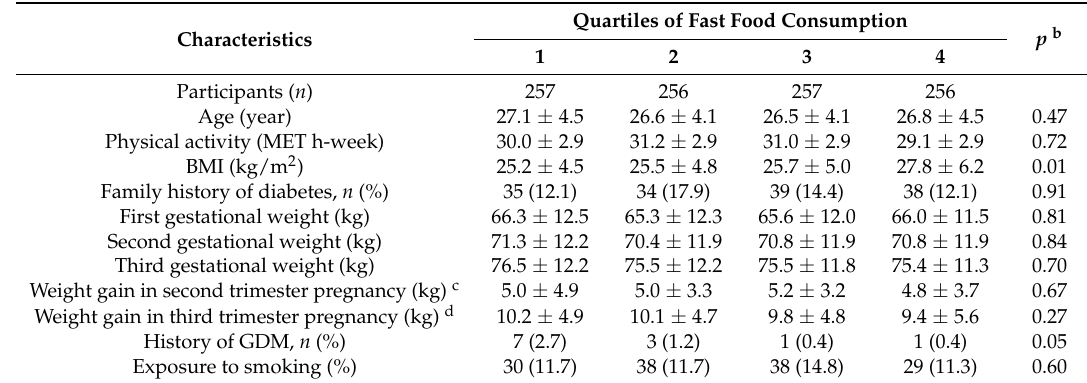
Table 1. Characteristics of participants by quartiles of fast food consumption a .